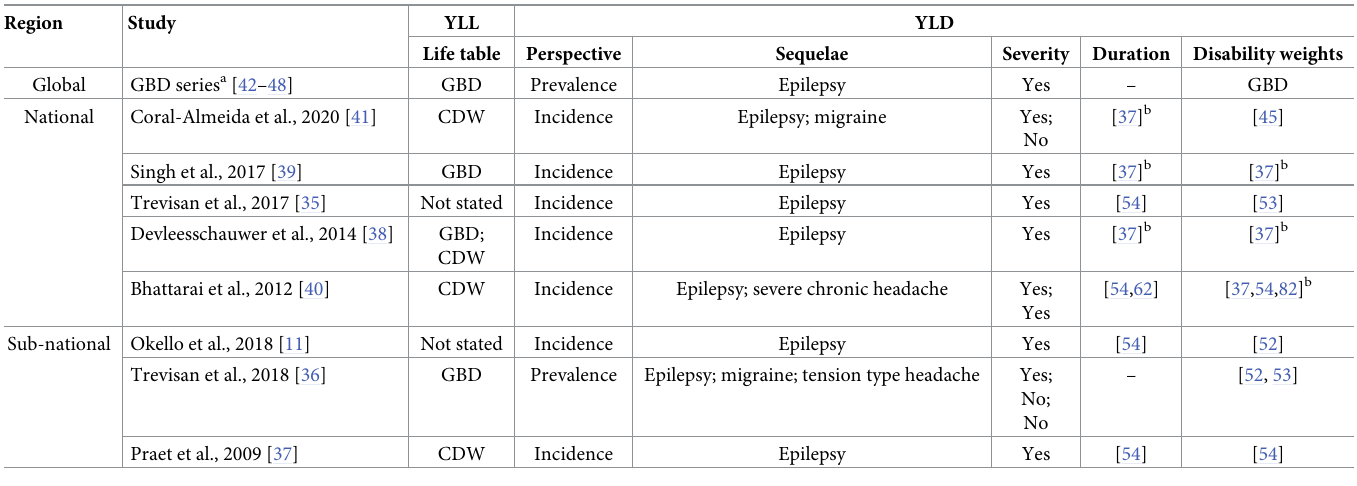
Table 2. A summary of YLL and YLD